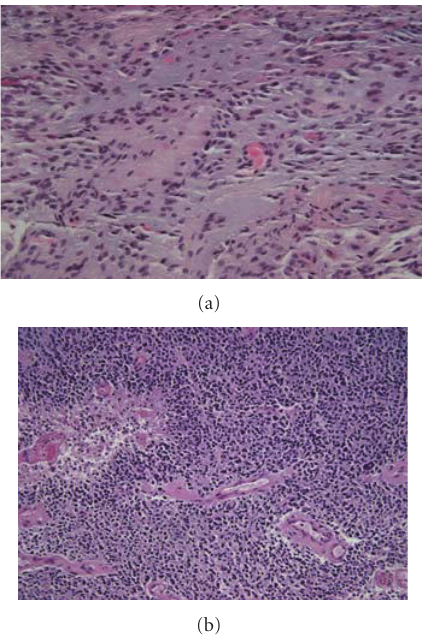
Figure 2: Histopathology of Primary JPA and sGBM. Tumor at original diagnosis reveals a hypercellular biphasic pattern of solid and cystic neoplasm with bland nuclei, and microvascular proliferation consistent with a diagnosis of low-grade glioma (a) (40x magnification, hematoxylin-eosin stained) Posterior fossa tumor 9 years after initial diagnosis reveals nuclear atypia with numerous mitosis, vascular proliferation, and pseudopalisading necrosis consistent with a diagnosis of glioblastoma multiforme (b) (20x magnification, hematoxylin-eosin